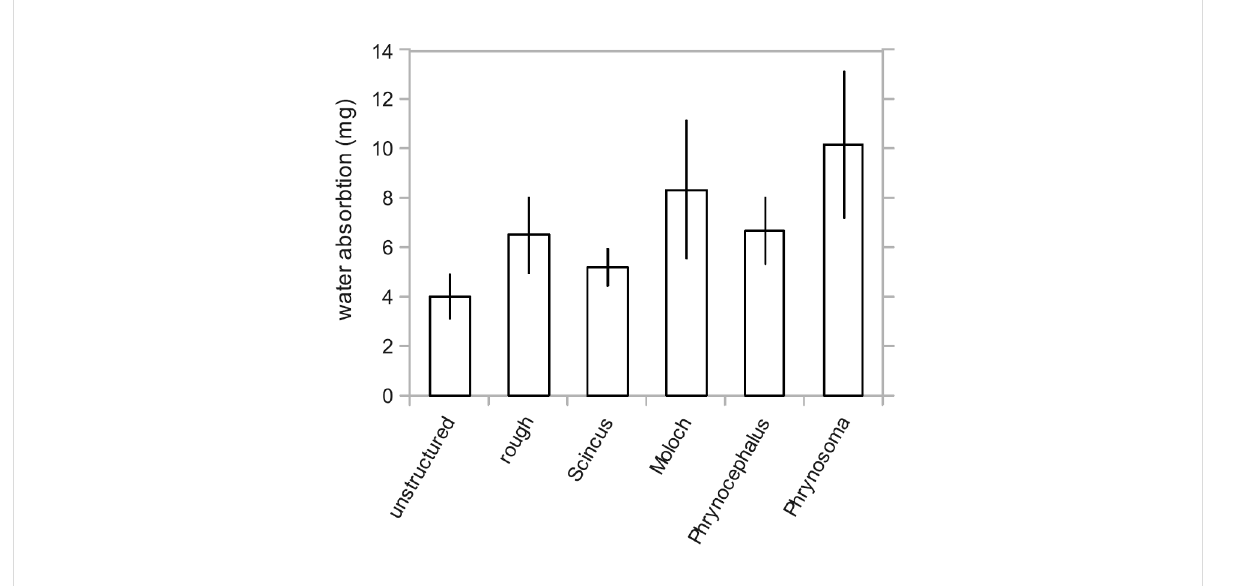
Figure 7: Water condensation on epoxy replicas of structured surfaces. The epoxy replicas were cut into disks with a diameter of 15 mm. These disks were thermally equilibrated to 20.5 °C and then held for 15 s in water-saturated air at a temperature of 80 °C. The amount of water was determined by the mass difference of each replica. Clearly structured surfaces allow for more condensation when compared with unstructured ones. Even an unspe- cific roughness introduced by polishing paper (roughness, R a ≈ 3 µm) increased the amount of water, although not significantly (p = 0.070). The replica of a non-moisture harvesting lizard Scincus scincus exhibits no significant increase of the condensation (p = 0.093). The replicas of the mois- ture harvesting lizards Moloch horridus (p = 0.032), Phrynocephalus arabicus (p = 0.034) and especially Phrynosoma cornutum (p = 0.007) show a significantly increased water condensation. Significance was tested by use of a two sided t-test assuming different standard deviations for the